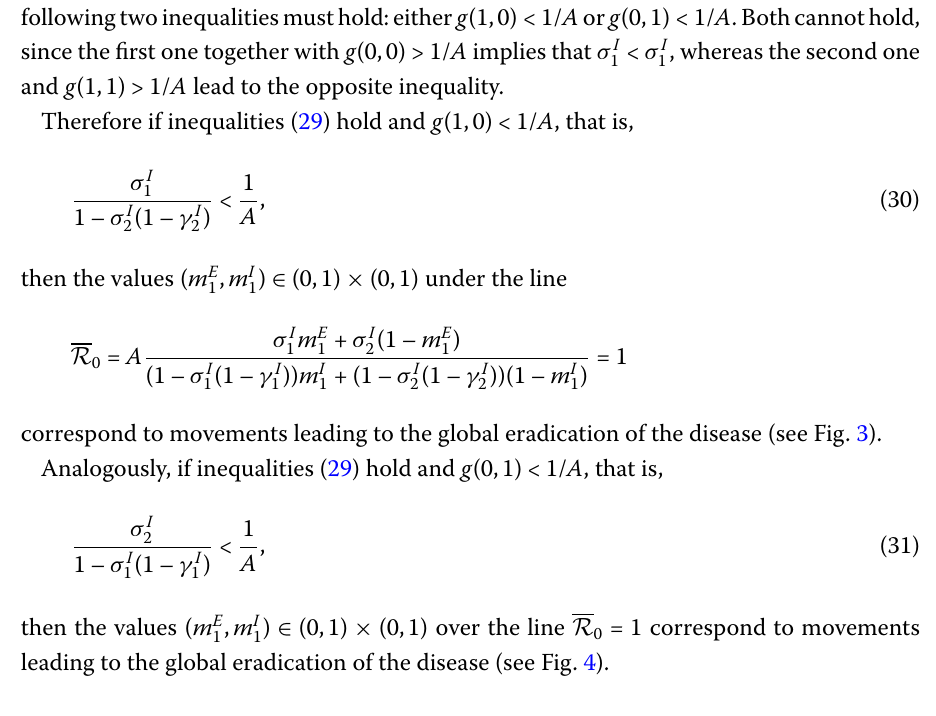
following two inequalities must hold: either g (1,0) < 1/ A or g (0,1) < 1/ A . Both cannot hold, since the first one together with g (0,0) > 1/ A implies that σ I